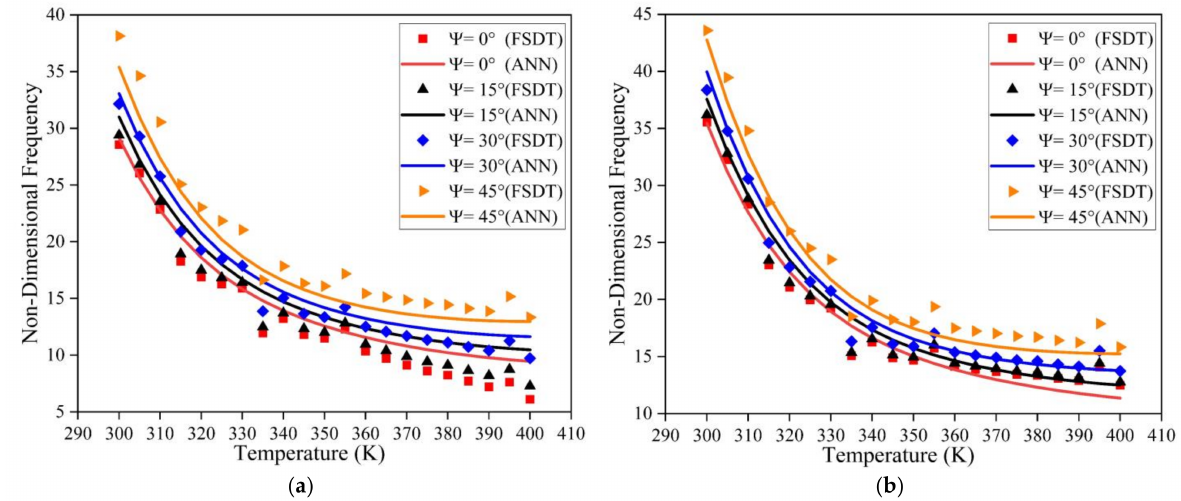
Figure 8. Influence of thermal environment on the fundamental frequency of the LCS plate under ( a ) SSSS and ( b ) CCCC boundary